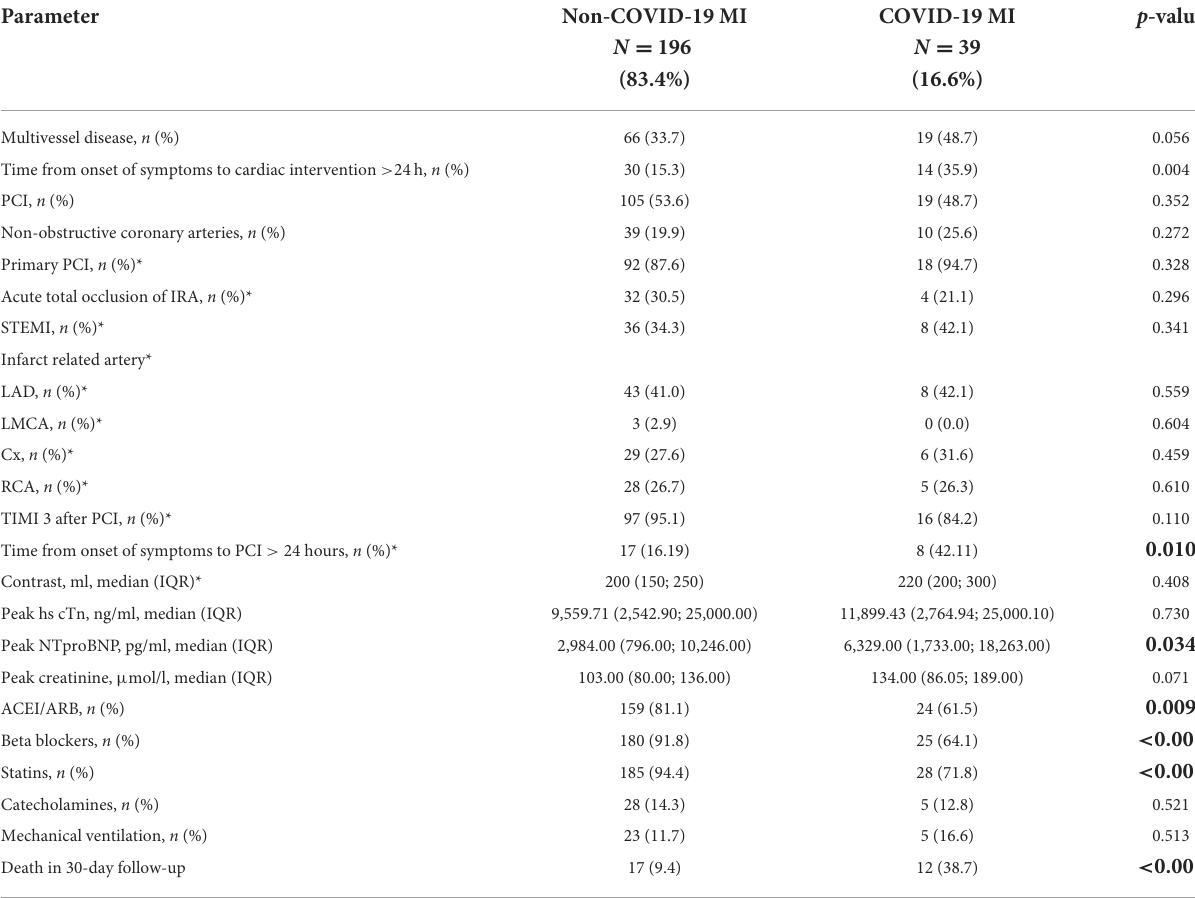
TABLE 3 Angiography results, in-hospital drug therapy and patient’s outcome among non-COVID-19 MI and COVID-19 MI group. Parameter Non-COVID-19 MI